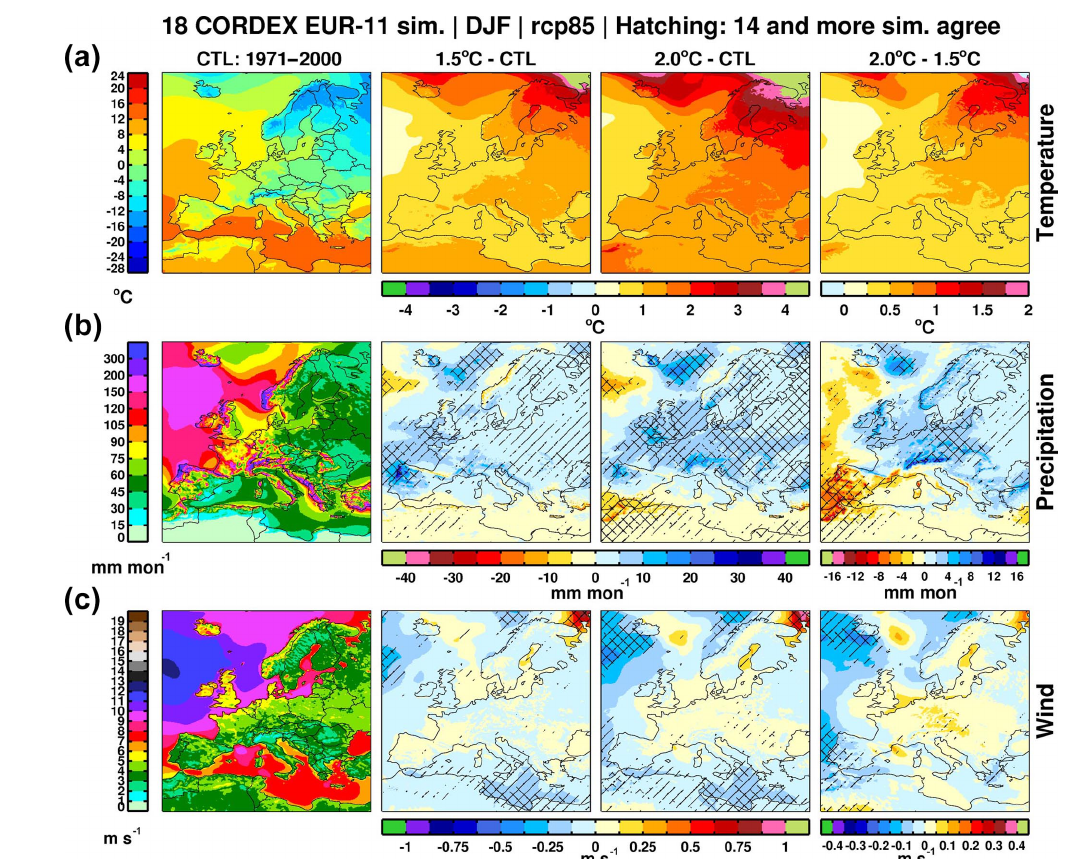
Figure 4. Ensemble mean winter (DJF) 2m temperature (a) , precipitation (b) and 10m wind speed (c) in the control period (left), its change at SWL1.5 (second column) and SWL2 (third column), and the difference between the change at SWL2 and SWL1.5 (rightmost column). Hatching in the climate change signal for precipitation and wind speed represents areas where at least 14 of the 18 ensemble members agree on the sign of change (for temperature this is always the case). Cross-hatching indicates that there is agreement on the sign of change and that the signal-to-noise ratio is larger than 1. Hatching in the rightmost plots indicates that changes at SWL2 are larger than those at SWL1.5 in at least 14 of the